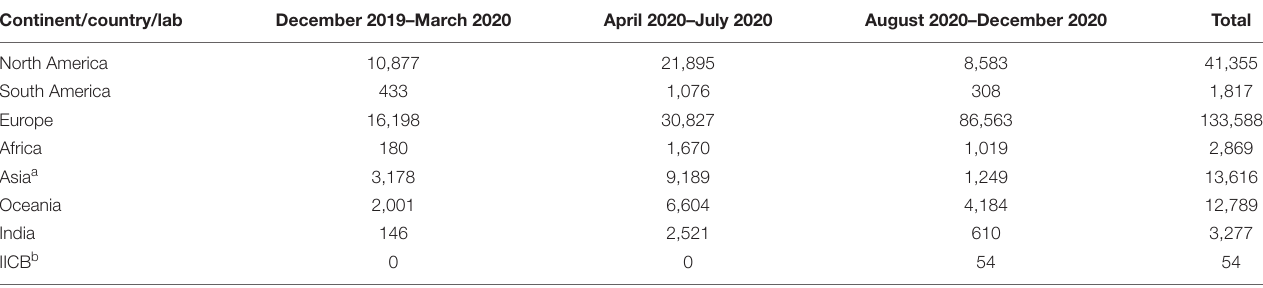
TABLE 1 | Number of sequences deposited in the year